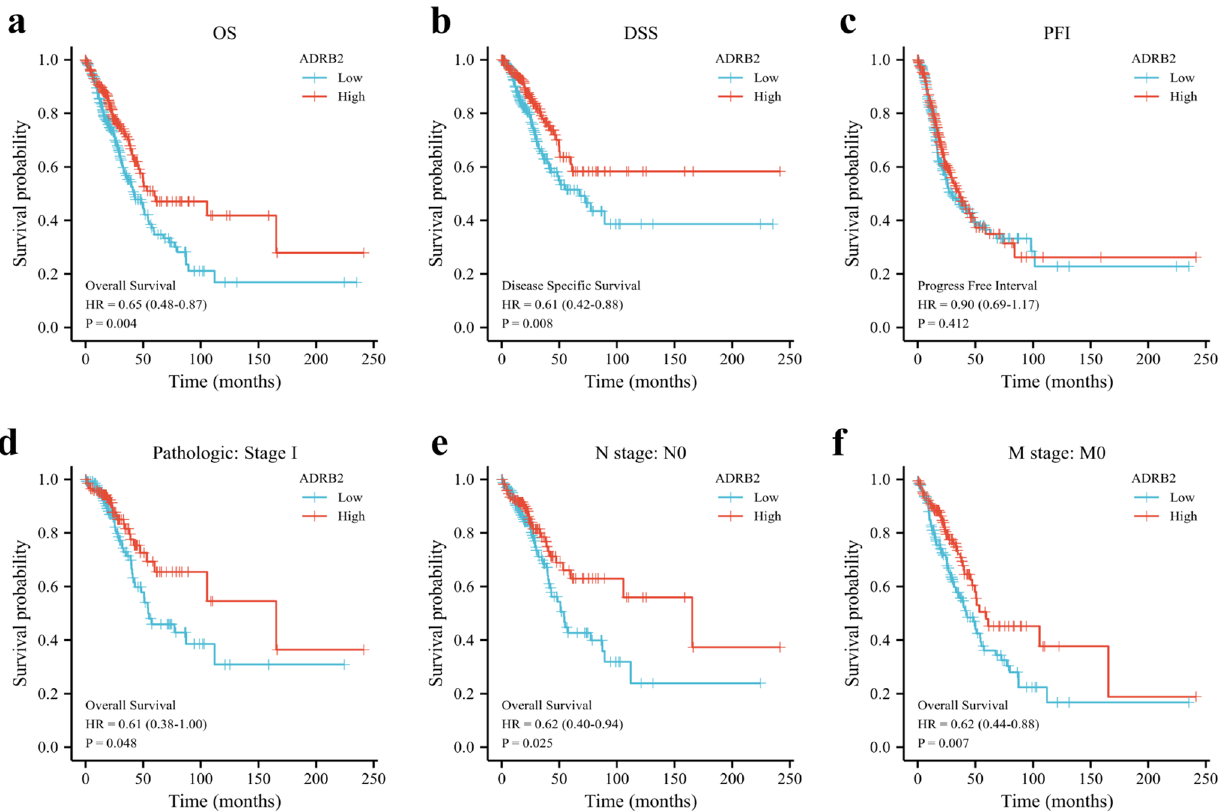
Figure 4. The prognostic value of ADRB2 in the differernt subgroups. Survival analysis of ADRB2 expression in LUAD patients: OS ( a ), DSS ( b ), and PFI ( c ). Low expression of ADRB2 was associated with worse OS in different subgroups ( d – f ).